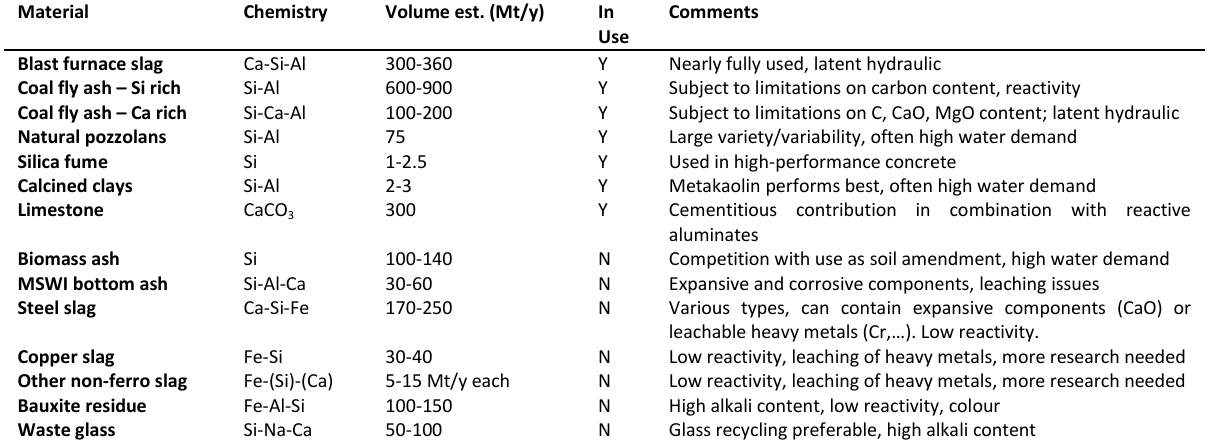
Table 2. Overview of materials used or considered as SCMs: chemical composition, volume estimates and comments regarding application as SCM.